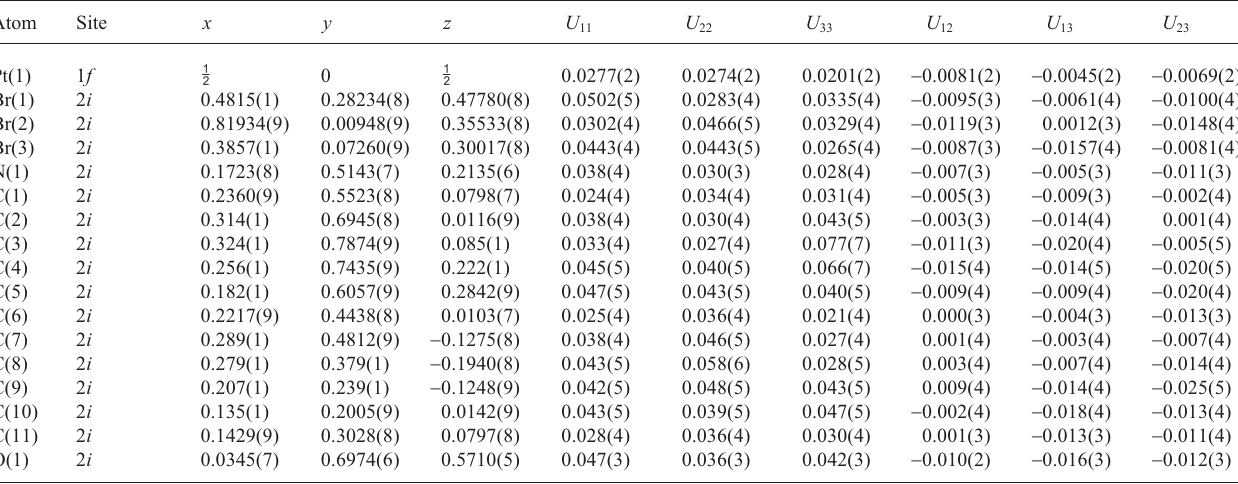
Table 3. Atomic coordinates and displacement parameters (in Å 2 )